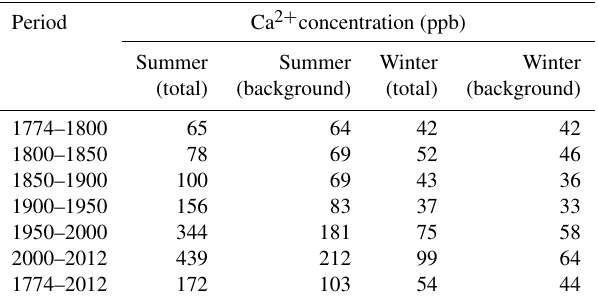
Figure 5. (a) Averaged concentrations of calcium and ammonium (used for determining seasonality as described in the text) over 1900–1950CE (a, c, e) and 1950–2010CE (b, d, f) . Total calcium concentrations are the grey bars in the top panels, while calcium concentrations calculated after the removal of samples are in red. The middle panels refer to calcium concentrations corresponding to the dust fraction (i.e. [Ca 2 + ] − [Ca 2 + red ], orange bars). Note that the equidistant binning of the summer and winter layers applied in order to derive these 12 values per year does not necessary corre- spond to monthly means. This would only be the case if there were an absence of seasonality in precipitation. Nevertheless, the figure clearly illustrates the occurrence of a dust-related calcium peak at the beginning of the summer season. Table 1. Ca 2 + concentrations in Elbrus ice cores from different periods – including total concentrations and excluding background samples from the large dust deposition events.